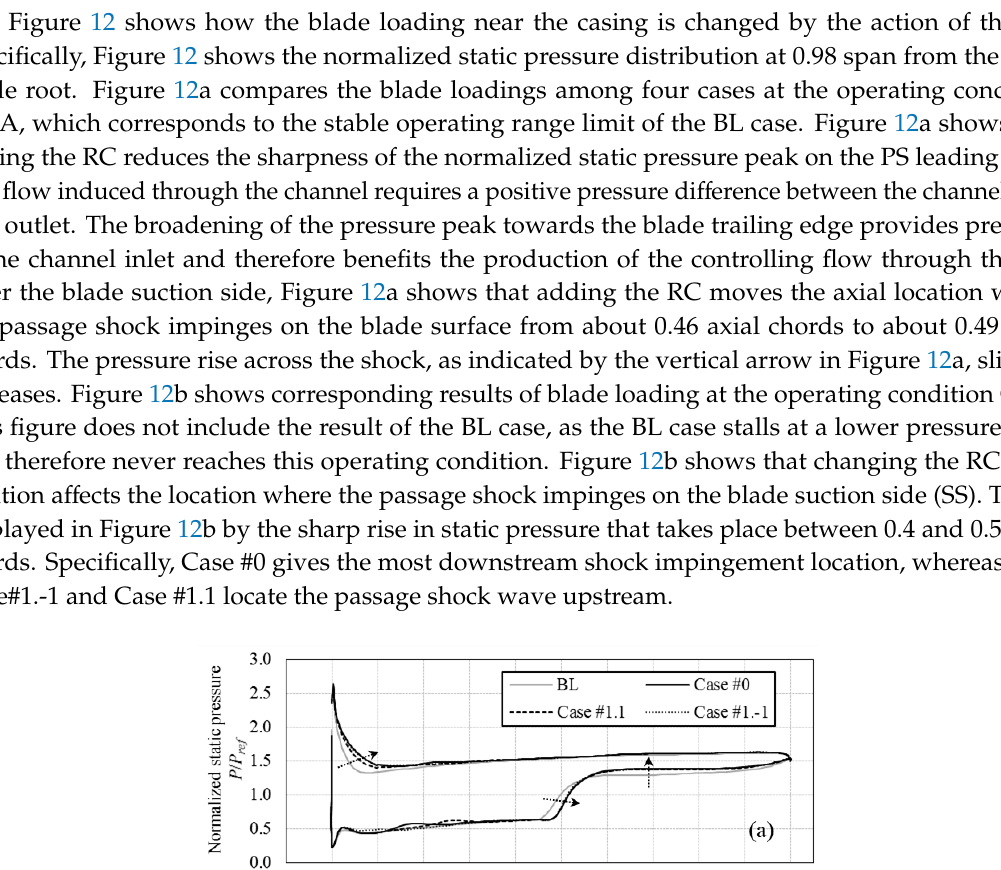
Figure 11. Visualization of the flow blockage mitigation on the shroud surface by the RC for different RC axial locations. Passage viewed from the hub towards the casing approximately in the radial direction. ( a ) BL (OP-A, NS). ( b ) Case #1.-1 (OP-A). ( c ) Case #1.-1 (OP-B, NS). ( d ) Case #0 (OP-A). ( e ) Case #0 (OP-B). ( f ) Case #1.1 (OP-A). ( g ) Case #1.1 (OP-B, NS).